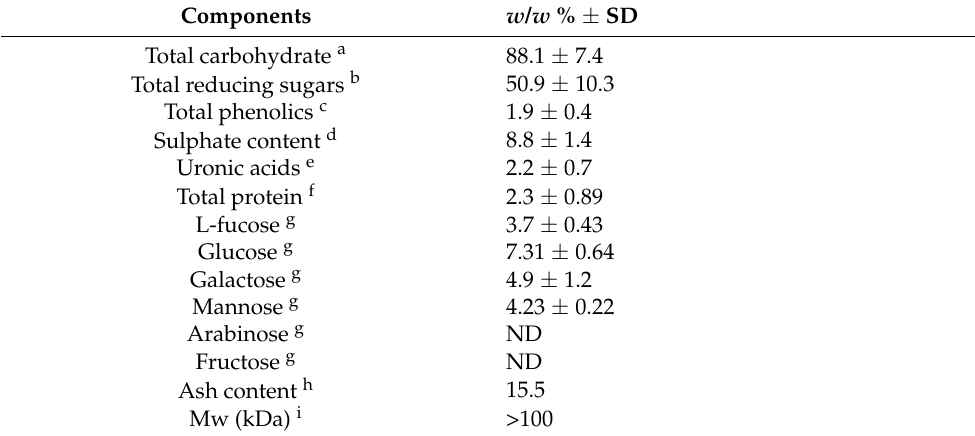
Table 1. Chemical composition of extracted E. radiata